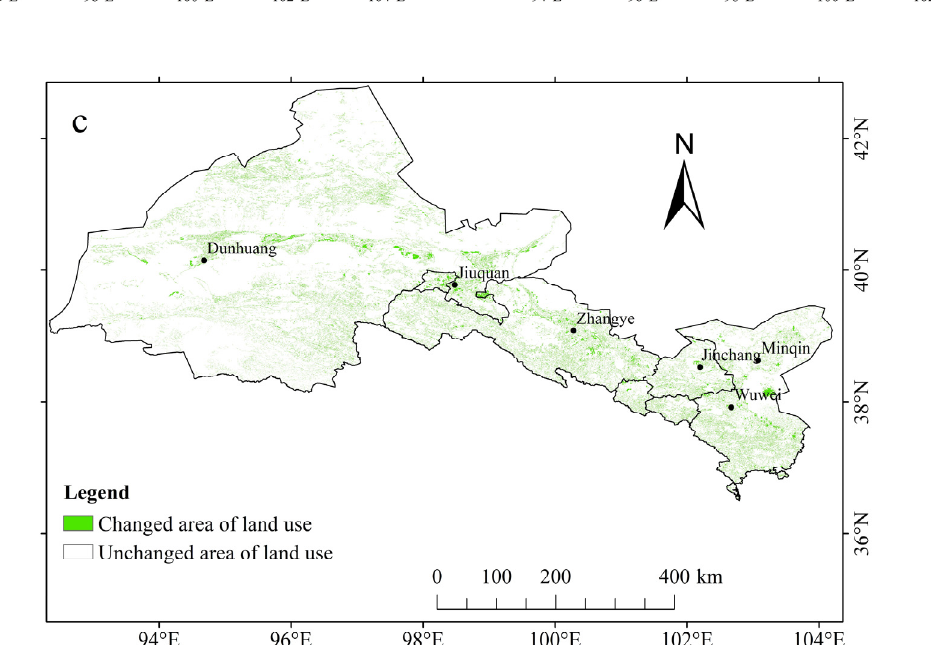
Table 2. Landscape pattern index of the entire Hexi Corridor.